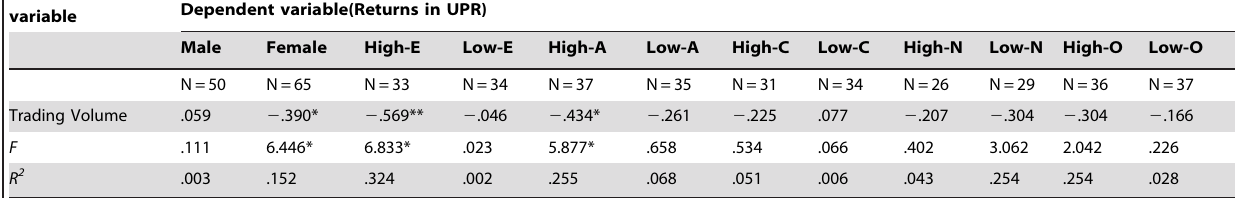
Table 5. Regression of Returns on Trading